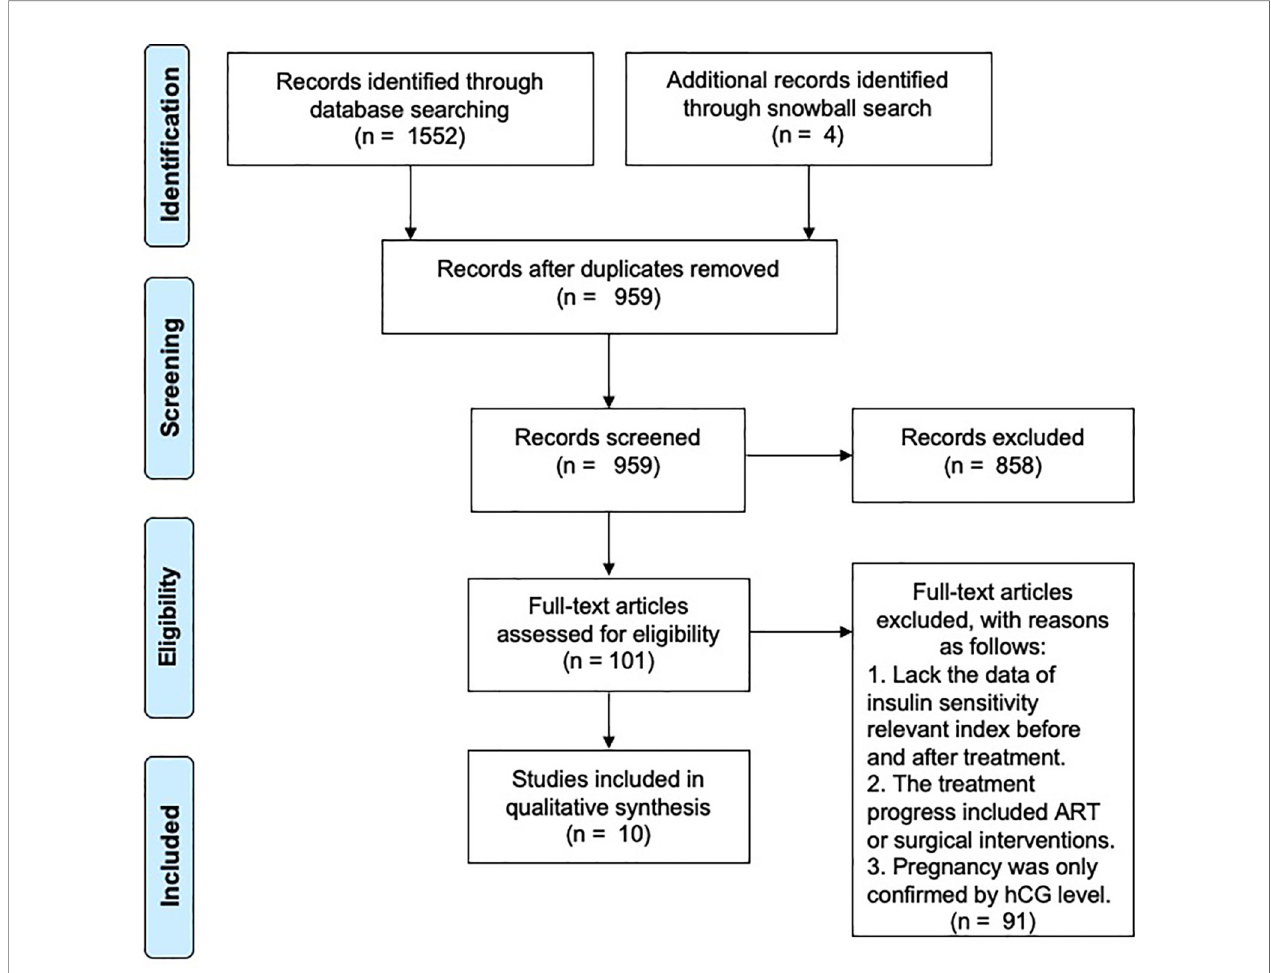
FIGURE 1 | Flow chart showing literature search and study